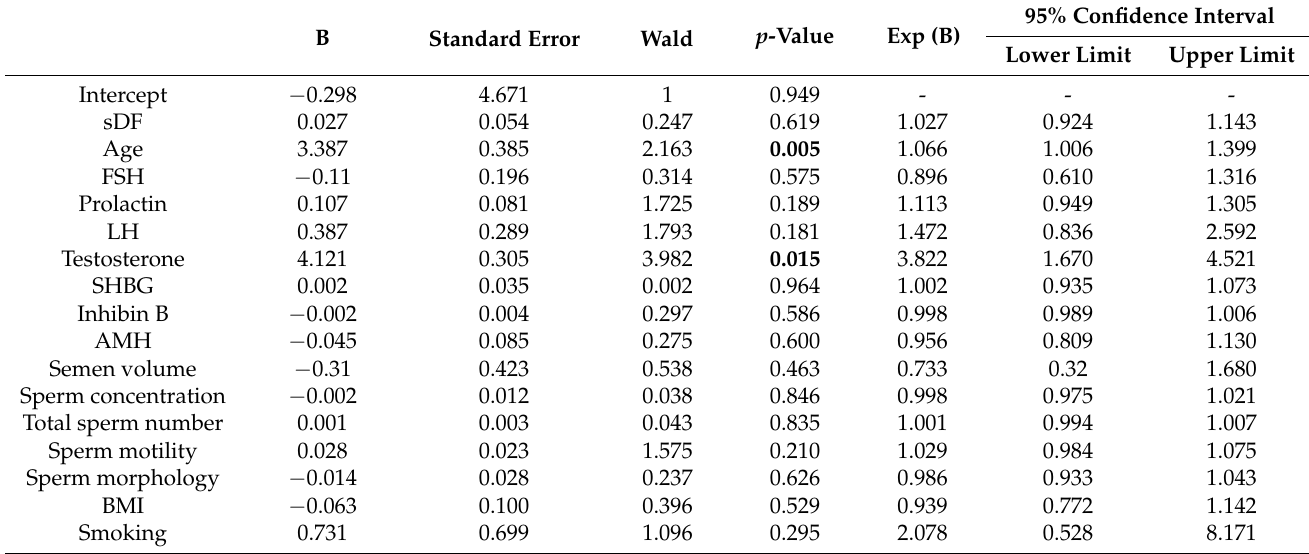
Table 6. Logistic regression analysis to predict patients with sperm DNA fragmentation index improvement. Bold characters reported statistically significant parameters.